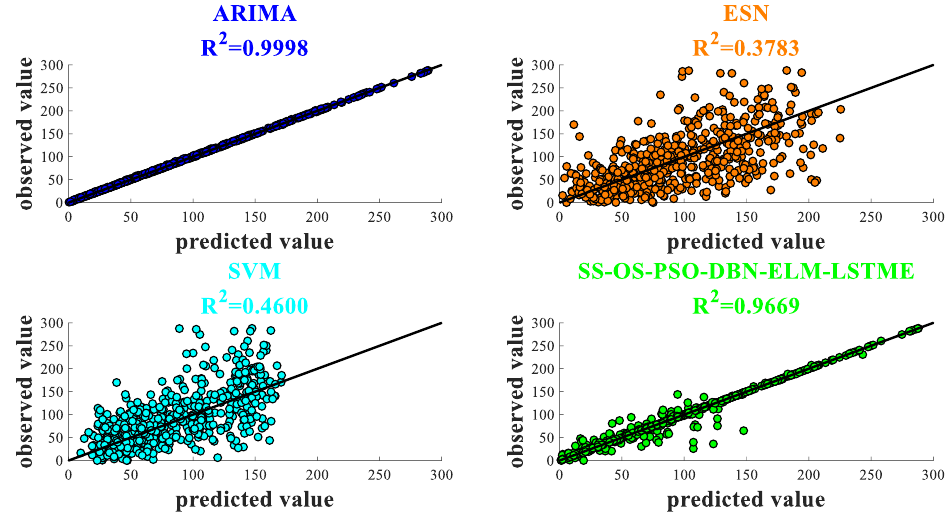
Figure 18. Scatter plots of observed and predicted rainfall (unit: mm) using M6–M9 models.